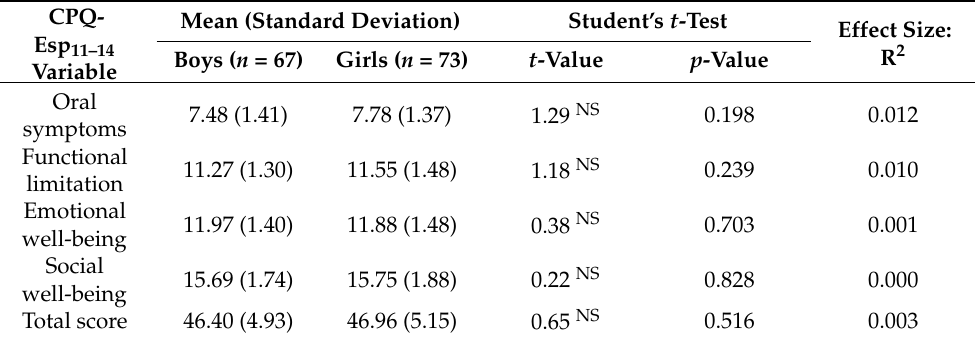
Table 2. Inferential analysis. Variables of the CPQ-Esp 11–14 questionnaire on OHRQoL according to sex ( n =